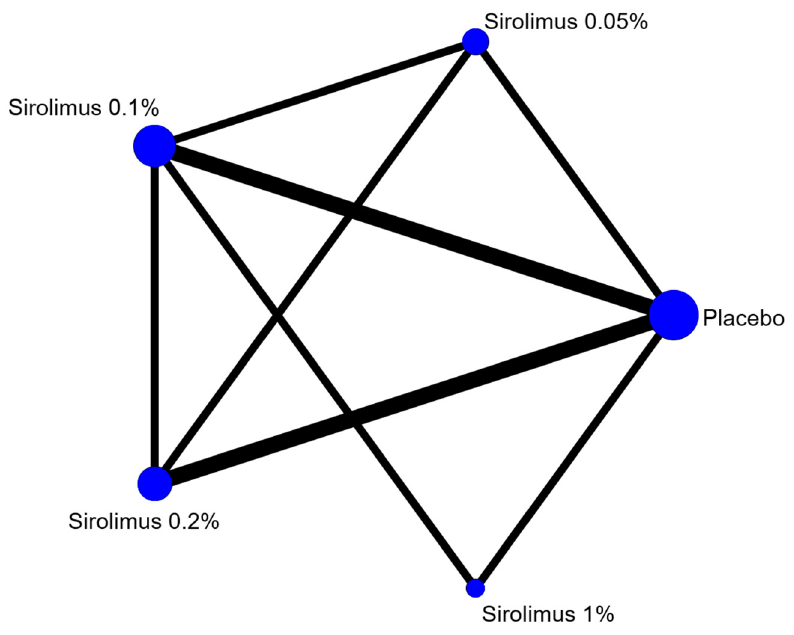
Figure 2. Geometry of comparisons in the network meta-analysis on clinical improvement.